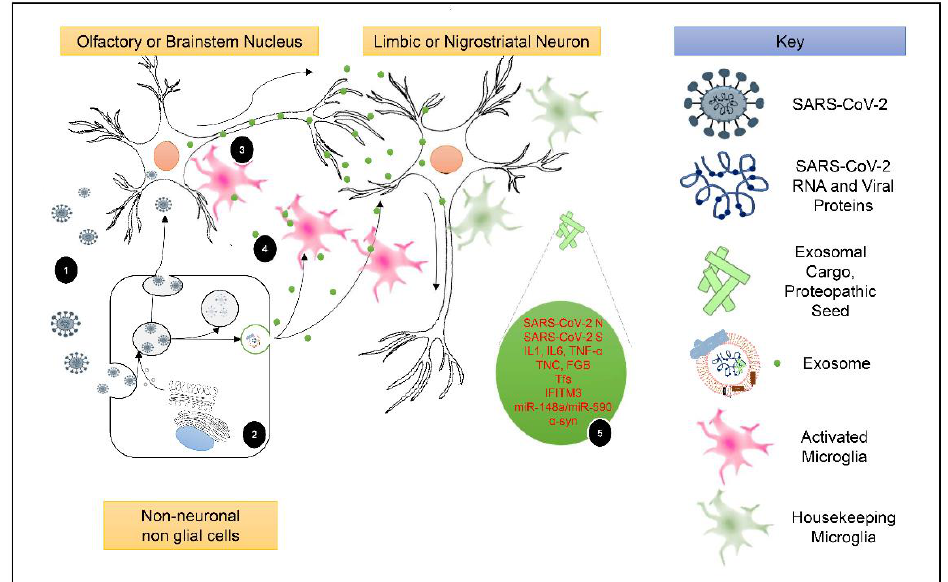
Figure 2. A hypothetical quasi-infectious model of CNS proteopathic seeding, with SARS-CoV-2 as the model virus. At step 1, SARS-CoV-2 neuroinvasion can occur either as a primary event by infecting neurons, or following infection of non-neuronal cells, such as brain endothelial cells, olfactory epithelial cells, or cells from peripheral infected tissues. Successful infection either of non-neuronal cells (2) or neurons (3) could lead to the production of exosomes that could be transmitted transynaptically (3), or intercellularly (4). The quasi-infectious concept indicates that the exosomal cargo is pathogenic and may be enhanced by the presence of viral components (5). SARS-CoV-2 S and N proteins could potentiate the formation of amyloid fibrils by endogenous α -syn in recipient cells. At the same time, exosomes could transmit α -syn to other brain cells in a “ prion-like ” mode. Exosomal immunomodulatory molecules could enhance neuroinflammatory processes in both neuronal and glia cells, while transcriptional regulators and miRNAs might activate intracellular signaling pathways and regulate gene transcription pertinent to neuroinflammation, oxidative stress, and other homeostatic cellular mechanisms. The ensuing microglial inflammatory phenotype turnover could enhance neuroinflammation further, resulting in enhanced neurodegeneration.